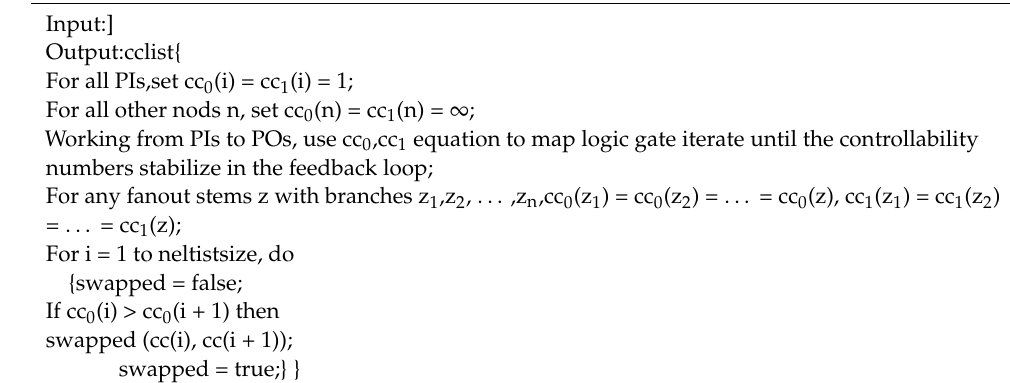
Algorithm 3. In the following, Algorithms 1–3 and the effect of each on the results of circuit obfuscation are described in detail. Algorithm 1: comput combinational controllability